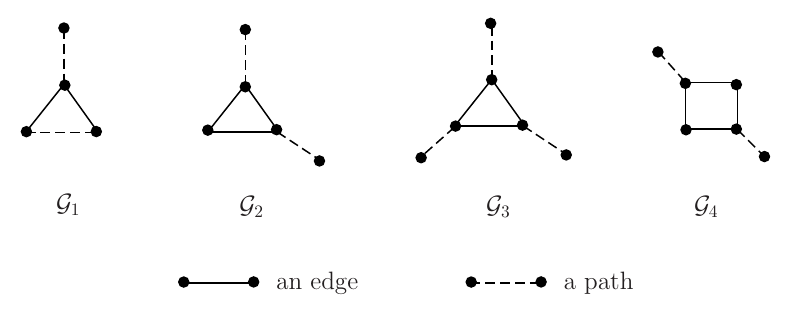
Fig 2: Unicyclic graphs with l ( G ) = 3.